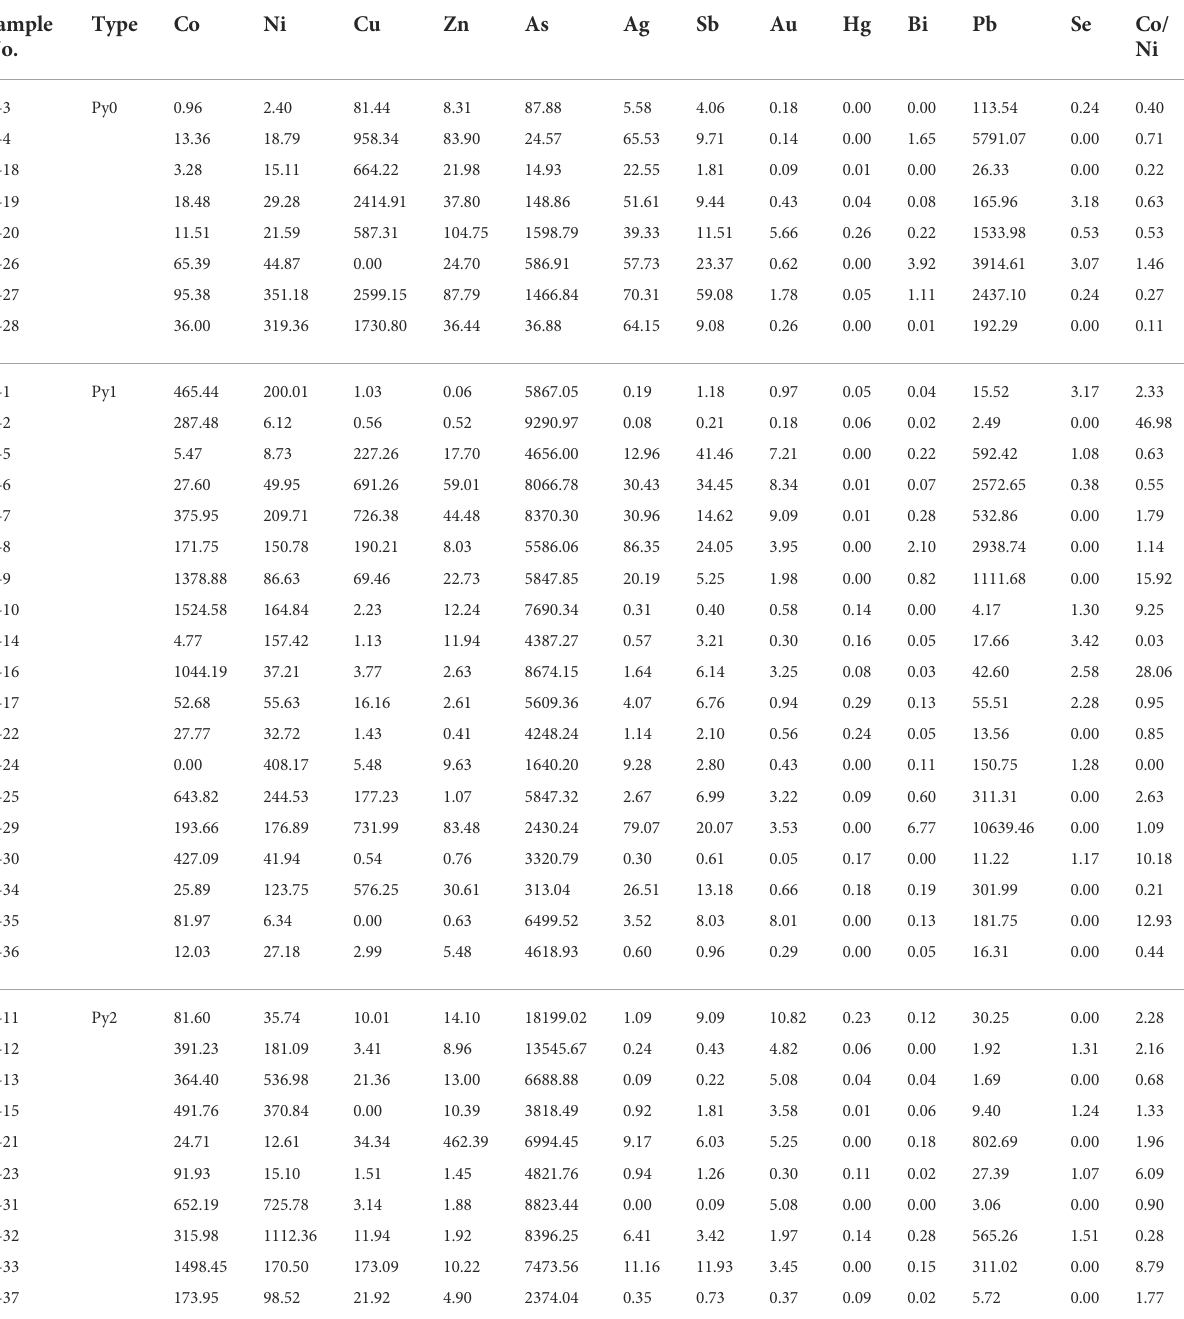
TABLE 2 Representative trace element concentrations (in ppm) of three pyrite types from the Houge ’ zhuang gold deposit analyzed by LA-ICP-MS. Sample